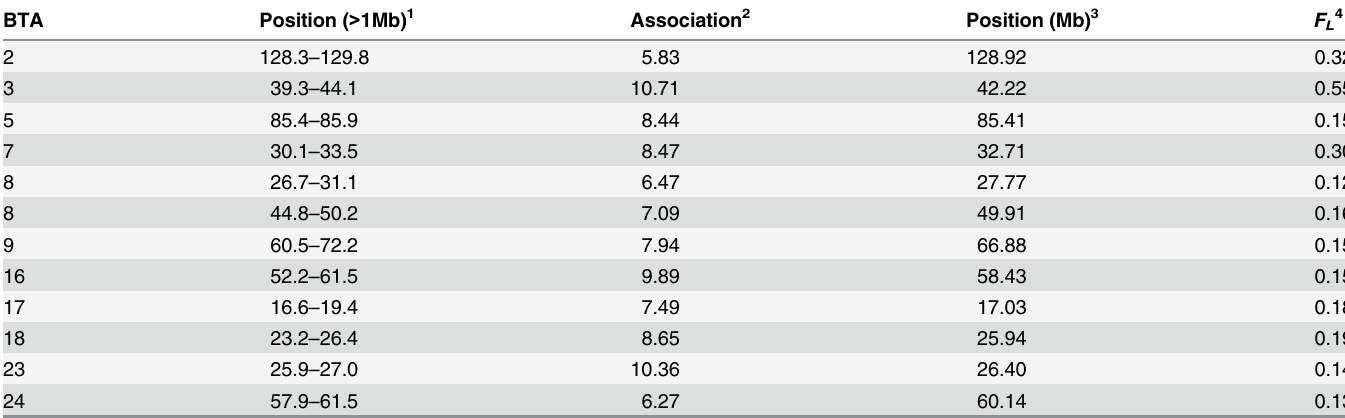
Table 2. ROH associated with FPED and birth year of animals.